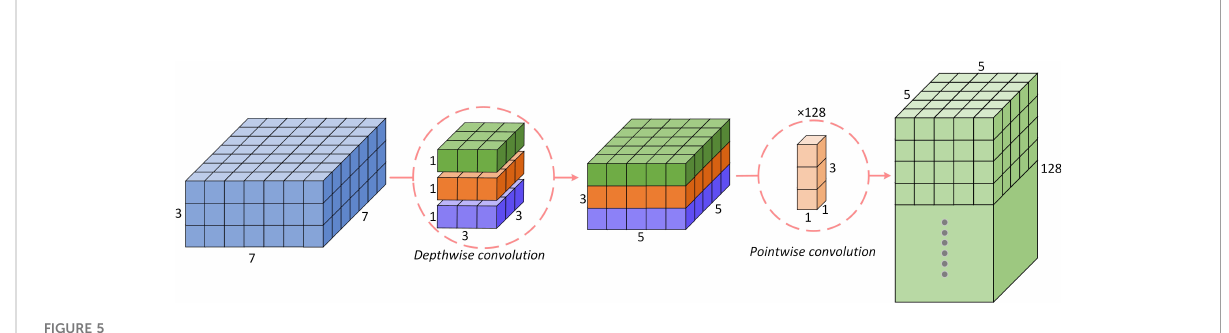
FIGURE 5 Depthwise separable convolutional